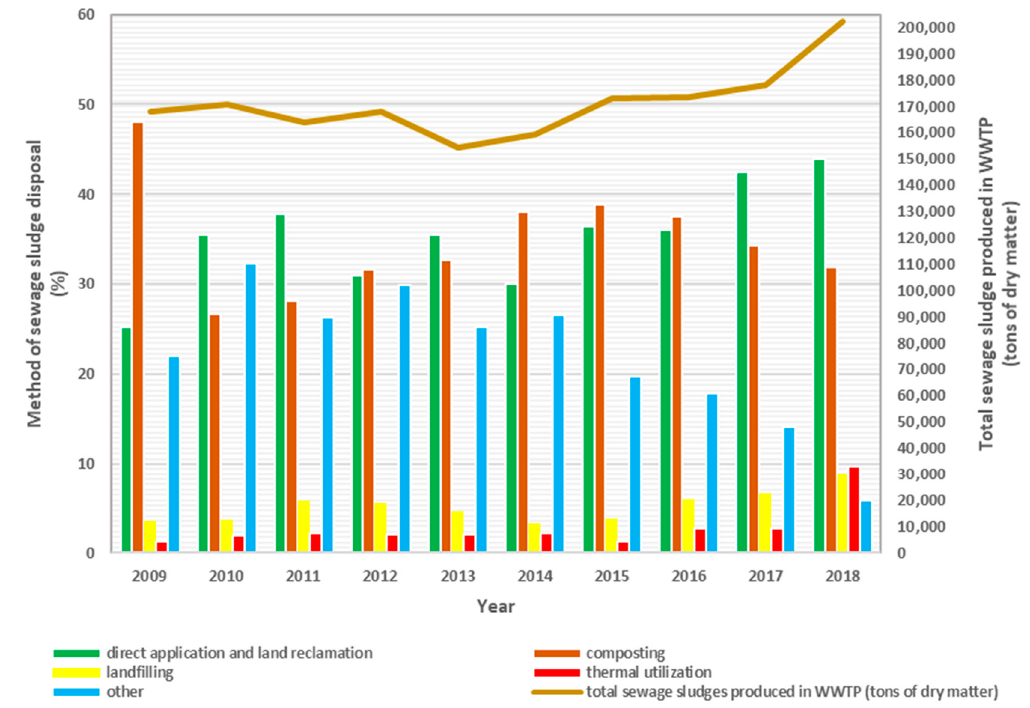
Figure 1. Proportional comparison of sewage sludge disposal in the Czech Republic in the years 2009–2018, modified according to [11].